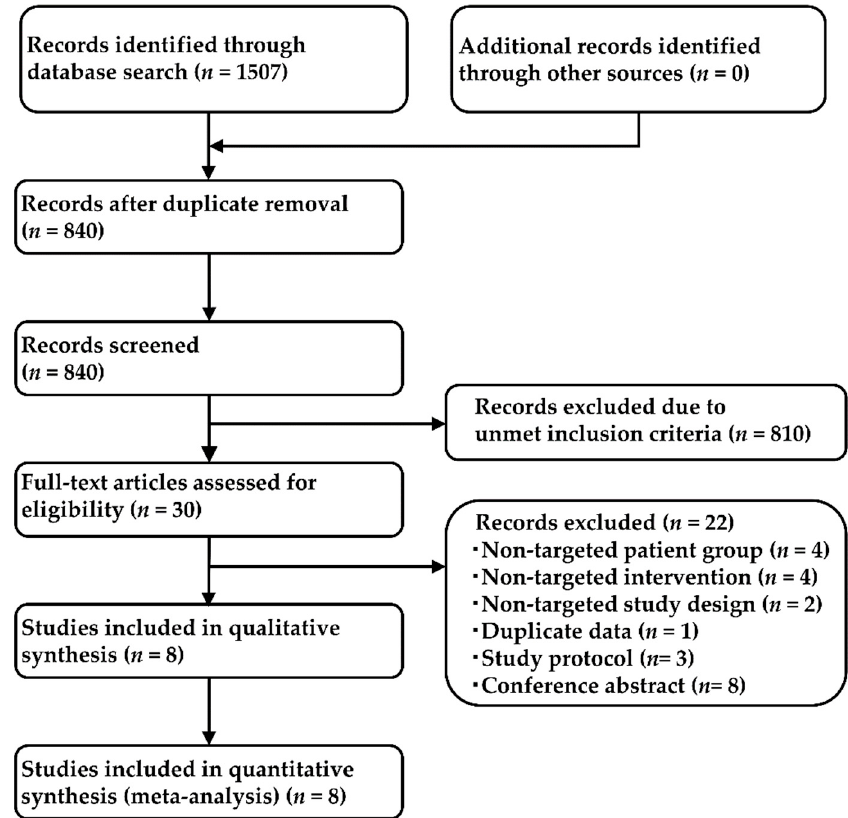
Figure 2. Flow chart depicting the process used for study selection. A total of 1507 studies (276 from PubMed, 196 from EMBASE, 661 from CENTRAL, and 374 from SCOPUS) were detected using a systematic literature review. After eliminating duplicates, 840 references remained; eight studies were finally selected for the NMA after adopting the PICOS approach.